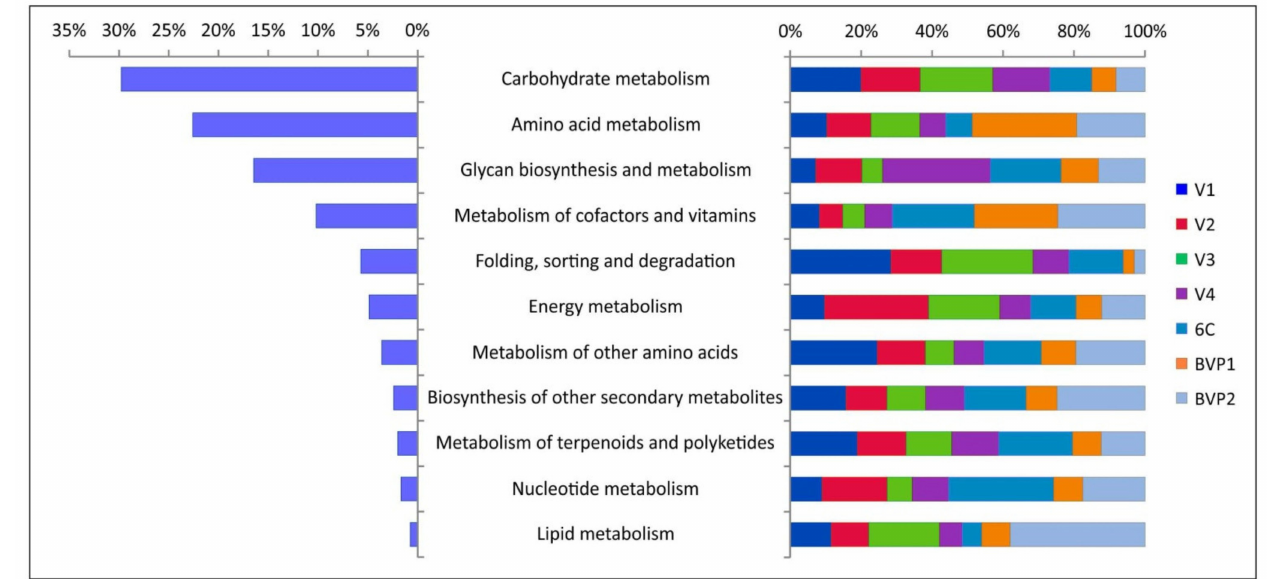
Figure 4. The main functional metabolic categories of auxiliary metabolic genes (AMGs) revealed in the virome datasets from Lake